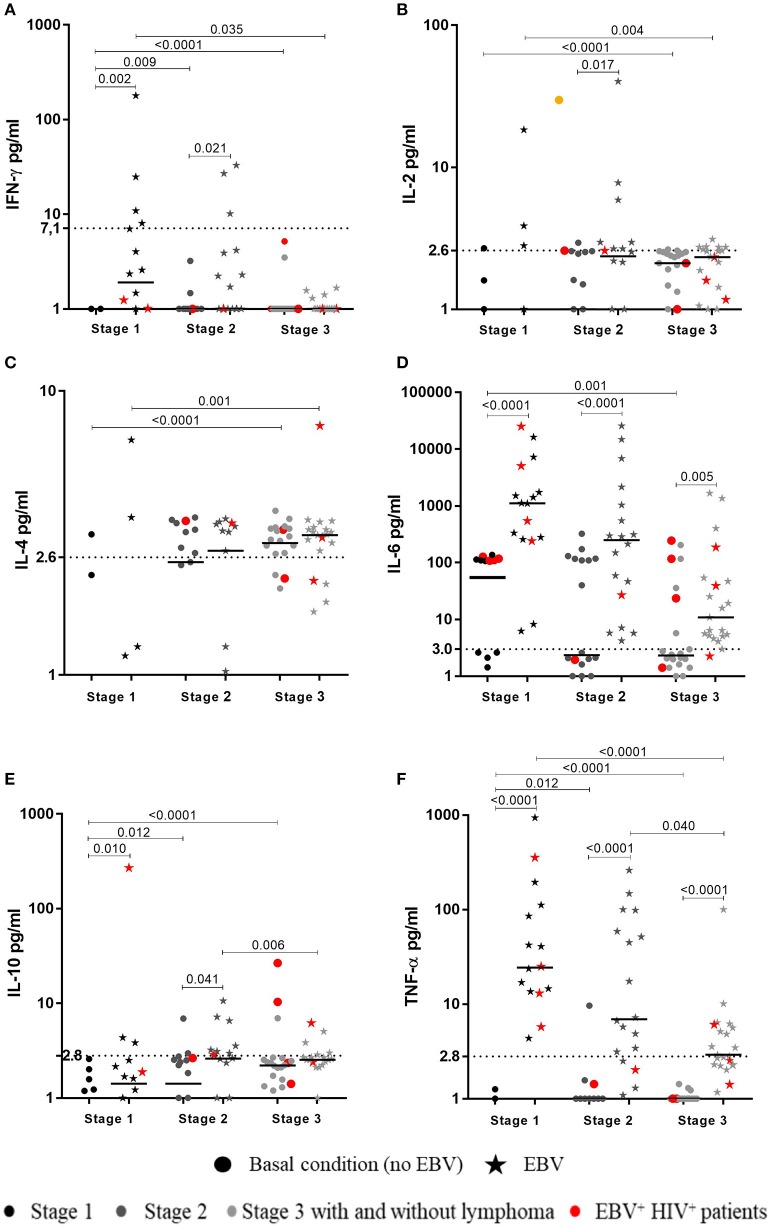
Cytokines synthesized in response to EBV by HIV+ patients. Peripheral blood samples of HIV+ patients at different stages of disease and healthy controls were cultured in vitro at basal (without EBV) and EBV-stimulated conditions without BFA. Supernatants were collected to measure the concentration (pg/mL) of cytokines by CBA and flow cytometry. The levels of IFN-γ (A), IL-2 (B), IL-4 (C), IL-6 (D), IL-10 (E) and TNF-α (F), are shown, respectively. Bold lines represent median values. Mann-Whitney U-test was used for comparisons between groups of individuals. Wilcoxon signed-rank Test was used for comparison between basal and EBV conditions. Dotted lines correspond to the limit of detection for every cytokine.